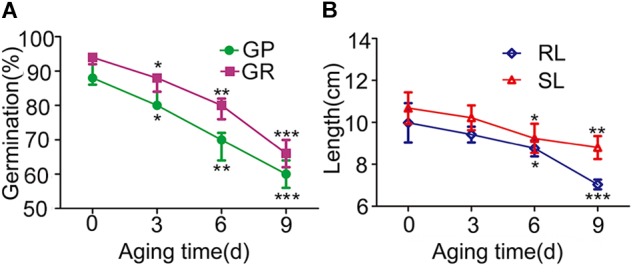
The seed vigor related traits of parent 9311 under artificial aging treatments. (A) The blue line with circle indicate germination potential (GP) with the accumulation of artificial aging treatment. The purple line with rectangle show germination rate (GR) under different artificial aging treatments. (B) The green line with rhombus indicate seedling length (SL) with the accumulation of artificial aging treatment. The orange line with triangle represent root length (RL) under various artificial aging times. We have compared the traits under artificial treatments with aging time 0 day. Two-way ANOVA method was used to calculate the P-value. All the abbreviations below represent the same meaning.∗p < 0.05; ∗∗p < 0.01; ∗∗∗p < 0.001.